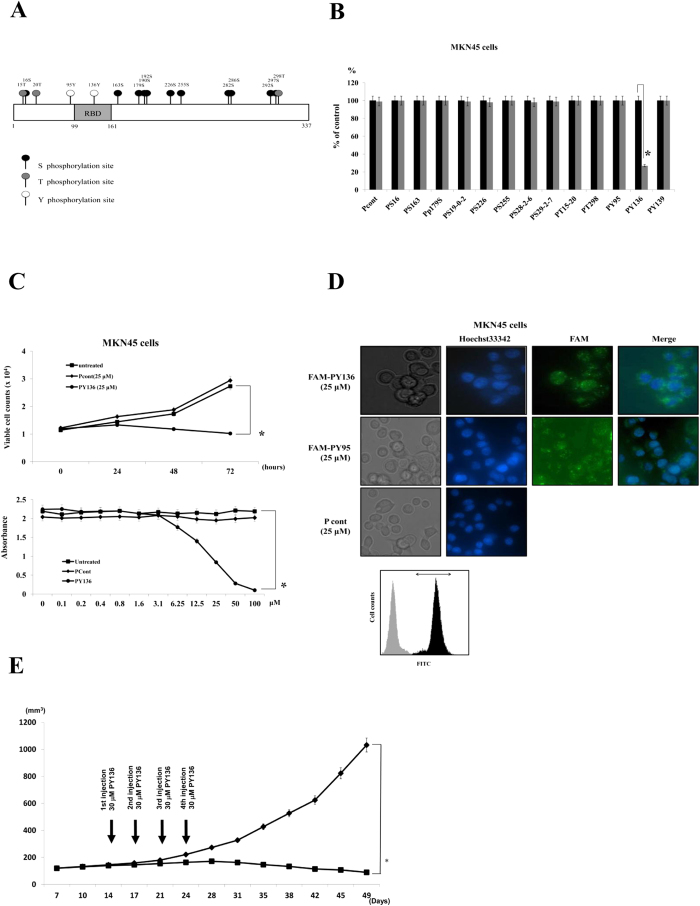
A LIX1L homeodomain peptide inhibits tumor growth.(A) A schematic diagram showing the domain structure of the human LIX1L protein containing a RBD, predicted serine phosphorylation sites, predicted threonine phosphorylation sites and predicted tyrosine phosphorylation sites. (B) The cell viability with viable cell counts. MKN45 cells were treated with the control peptide or one of 13 homeodomain peptides (50 μM) for 72 h. (C) The cell proliferation was assessed based on the viable cell counts (upper panel) and MTT assay (bottom panel) in cells treated with the indicated concentrations of peptides for 72 h. MKN45 cells were treated with Pcont (25 μM) and PY136 (25 μM). *p < 0.001 (D) Confirmation of 25 μM FAM-PY136 and 25 μM FAM-PY95 internalization (green) into non-permeabilized MKN45 cells after a three-hour treatment. The nuclei were stained using Hoechst 33342 (blue). The cells were viewed using phase-contrast and fluorescence microscopy, and 25 μM Pcont was used negative control. Representative images are shown (magnification, 400x) (upper panels). MKN45 cells treated with FAM-PY136 were analyzed using flow cytometry. Negative control MKN45 cells; light gray region, FAM-PY136-treated MKN45 cells; dark gray region (bottom panel). The arrow indicates the FITC-positive region. (E) Tumor treatment with PY136 (30 μM; n = 3). Cohorts of nude mice bearing size-matched human gastric cancer xenografts (MKN45-derived) were used for the in vivo studies. p < 0.05.